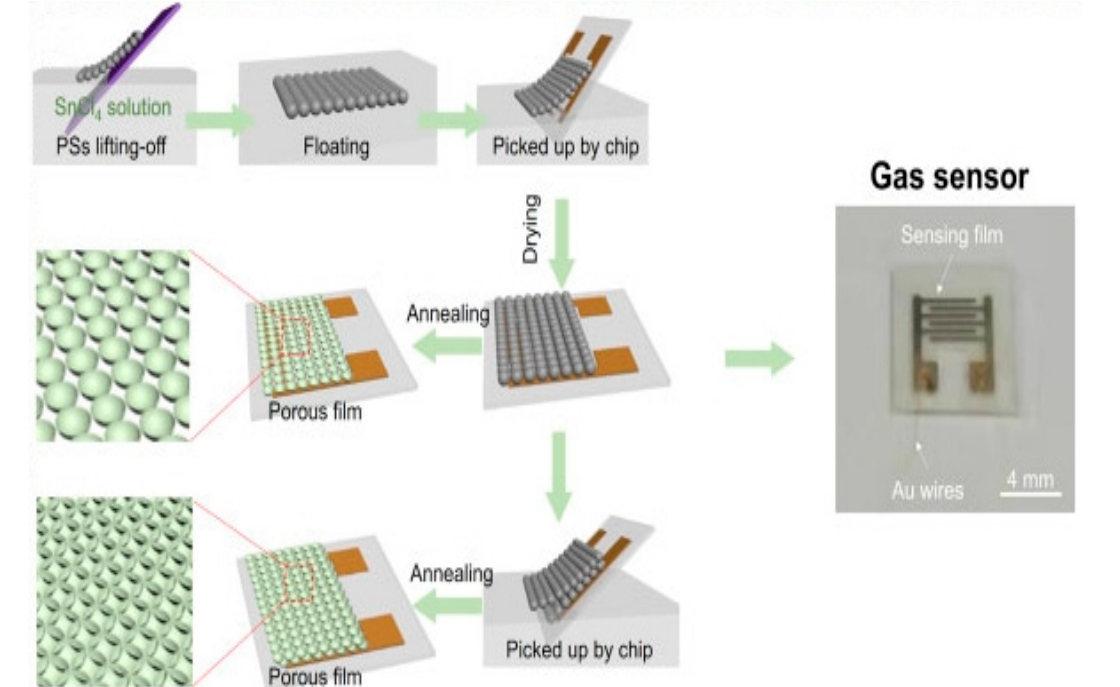
Figure 24. PS microspheres preparation of SnO2 porous membrane [91].